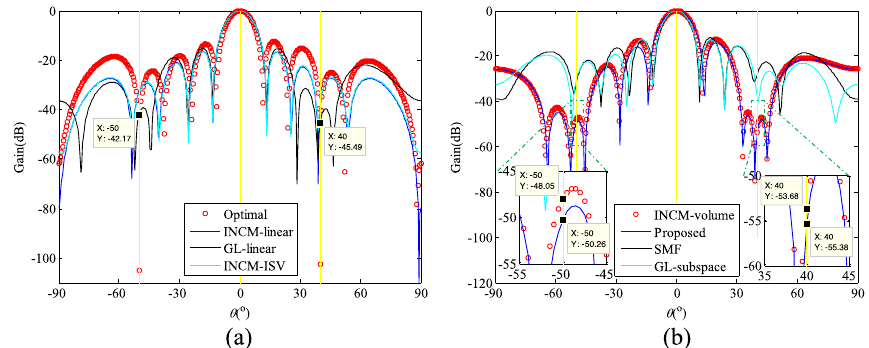
Fig. 9 Beam patterns for investigated participants. a First of two parts. b Second of two parts